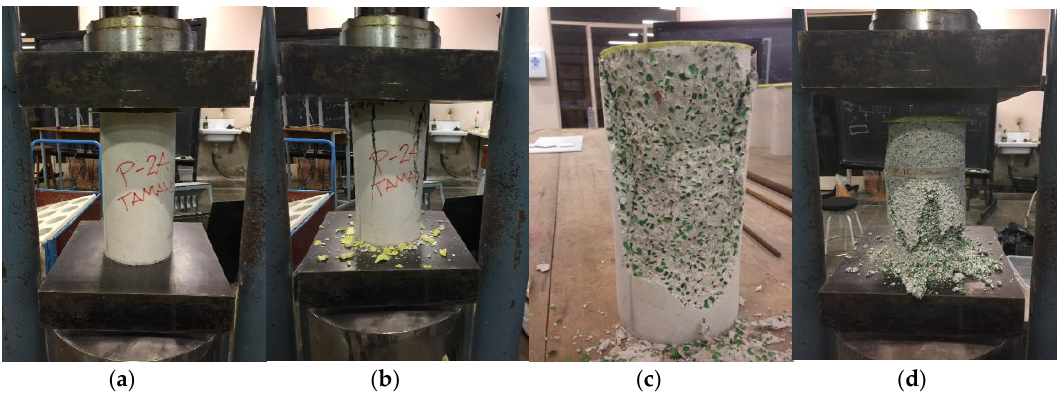
Figure 6. Tested Specimens under compression: ( a , b ) regular amount of glass; ( c ) double amount of glass, ( d ) triple amount of glass.